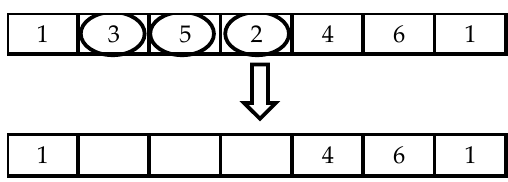
Figure 4. Example of related removal. Number 2 is a seed farm, number 3 and 5 are related farms.